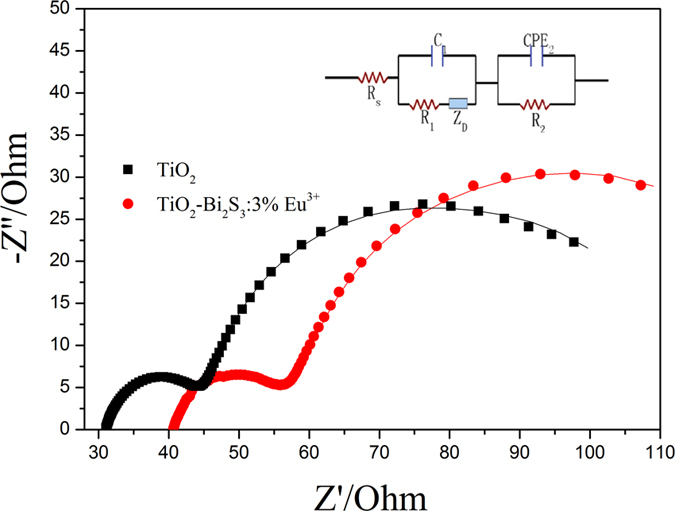
Nyquist plots of DSSCs comprised of pure TiO2 cell and TiO2-3%Bi2S3:Eu3+ cell.Inset is the equivalent circuit used to represent interfaces in composite solar cells composed of FTO|TiO2-dye|I−/I3−||Pt|FTO.